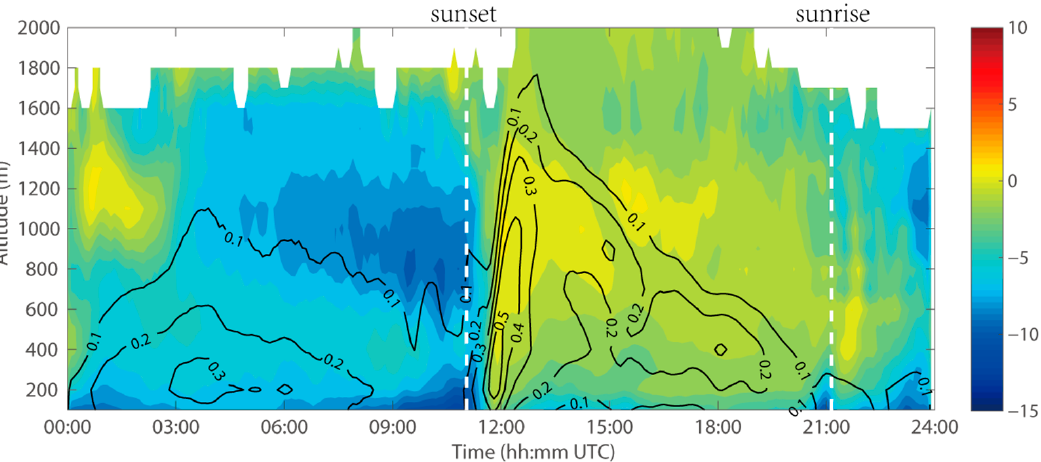
Figure 13. Time–height cross-section of Z (the fill color) and the valid data proportions (the black isopleths) for 24 h from the X-band radar at FS, Beijing, 2 May 2021.